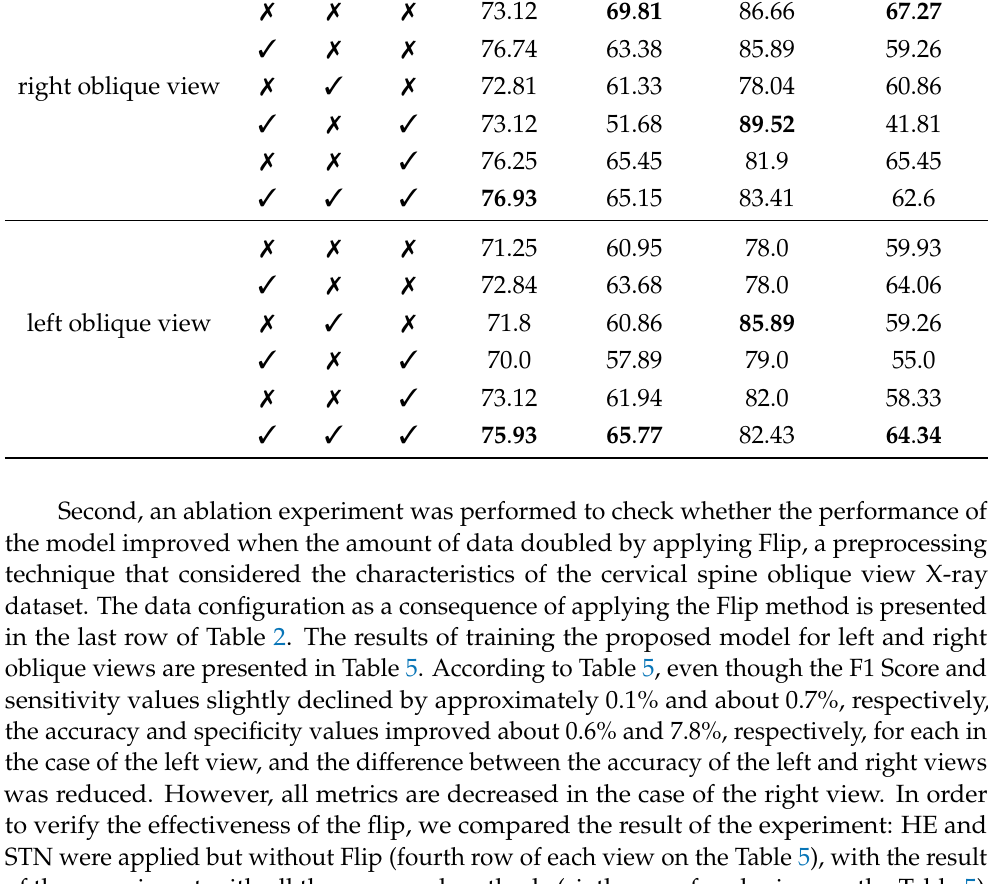
Table 5. Ablation experiment results from applying HE, Flip, and STN, respectively, for test dataset. The model is based on the fine-tuned ResNet50. HE Flip